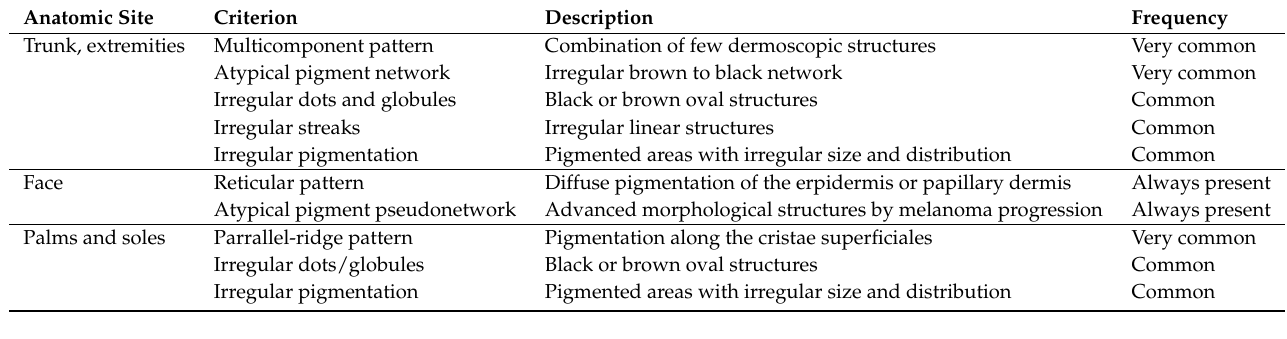
Table 1. Common melanoma-specific criteria for melanoma in situ and invasive melanoma detection according to the anatomic site of the body based on [2].